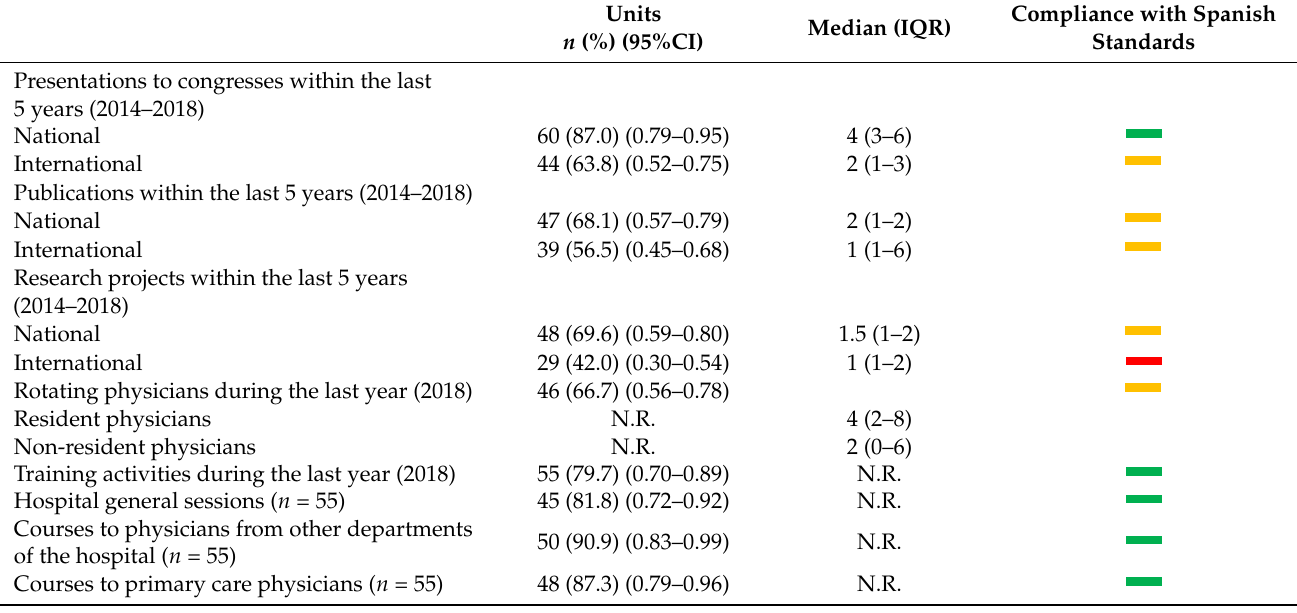
Table 3. Medical education and research activities in a sample of Spanish pain units ( n = 69).